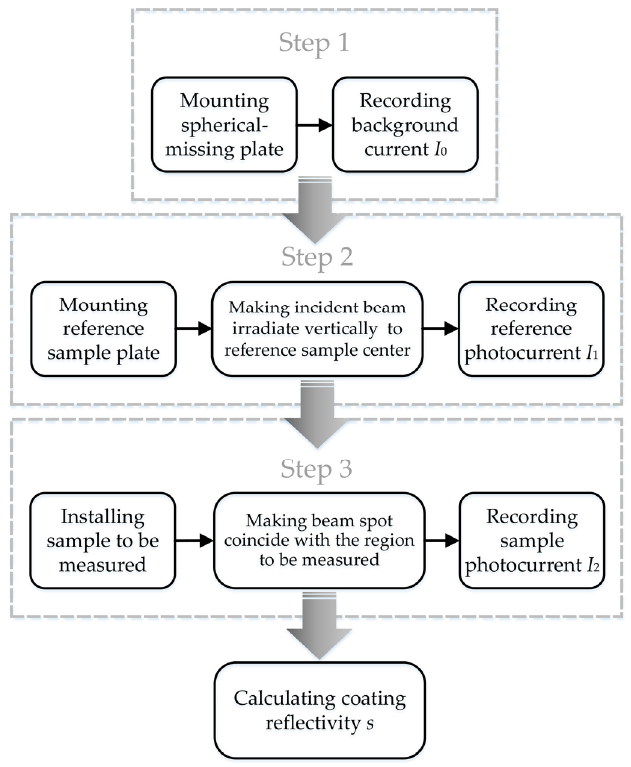
Figure 10. Flowchart of scattering-rate measurement. Table 1. Main technical parameters of the system.